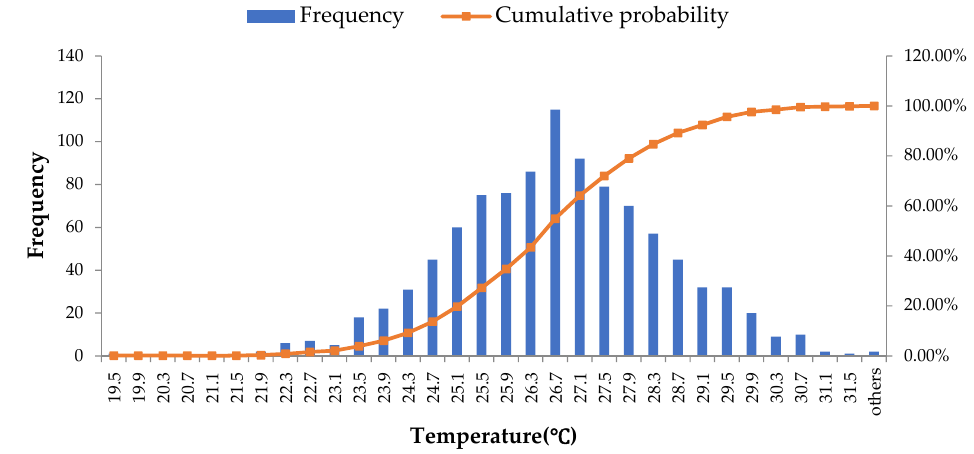
Figure 9. Histogram and the cumulative probability distribution of the T( h –1)*.